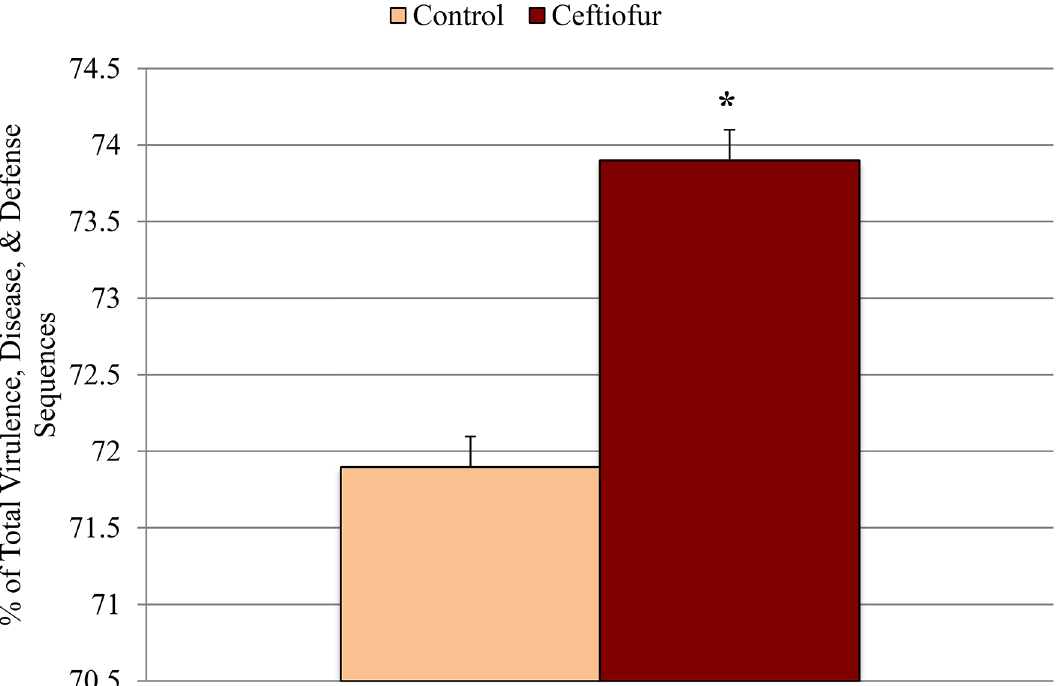
Fig 5. Abundance of “ resistance to antibiotics and toxic compounds (RATC) ” sequences in fecal samples collected from control (n = 3) and ceftiofur crystalline free acid treated (n = 3) cows on day 3 post-treatment. Day 0 (pre-treatment) samples were used as a covariate. Values are expressed as a percentage of the total “ virulence, disease, and defense ” sequences. The symbol * indicates significant differences ( P (cid:1)